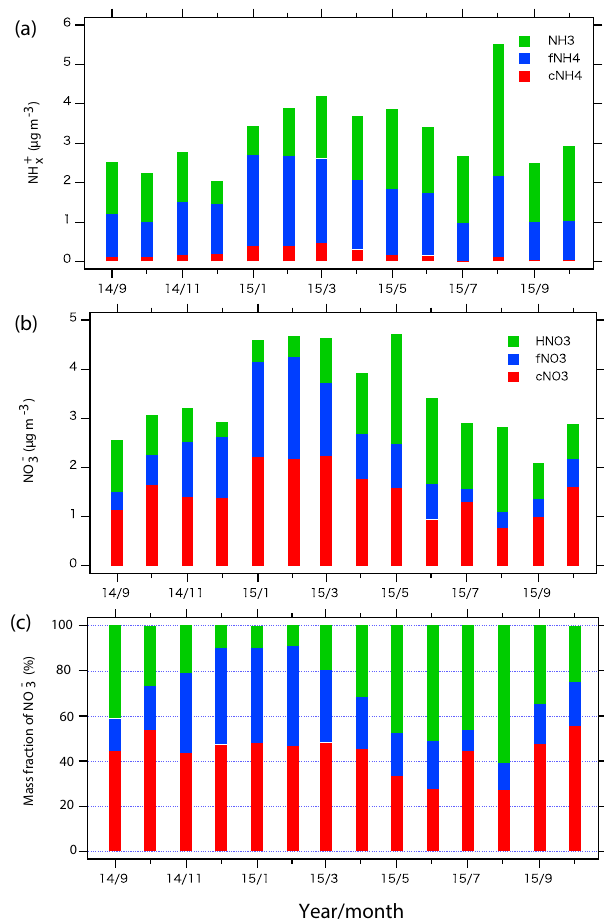
Figure 6. Monthly average values for (a) NH x , (b) NO 3 , and (c) the mass fraction (%) of NO 3 , observed by